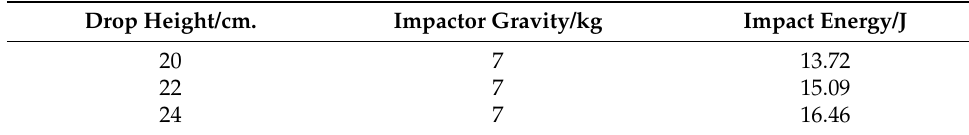
Table 3. The main parameters of the dynamic compression tests. Drop Height/cm. Drop